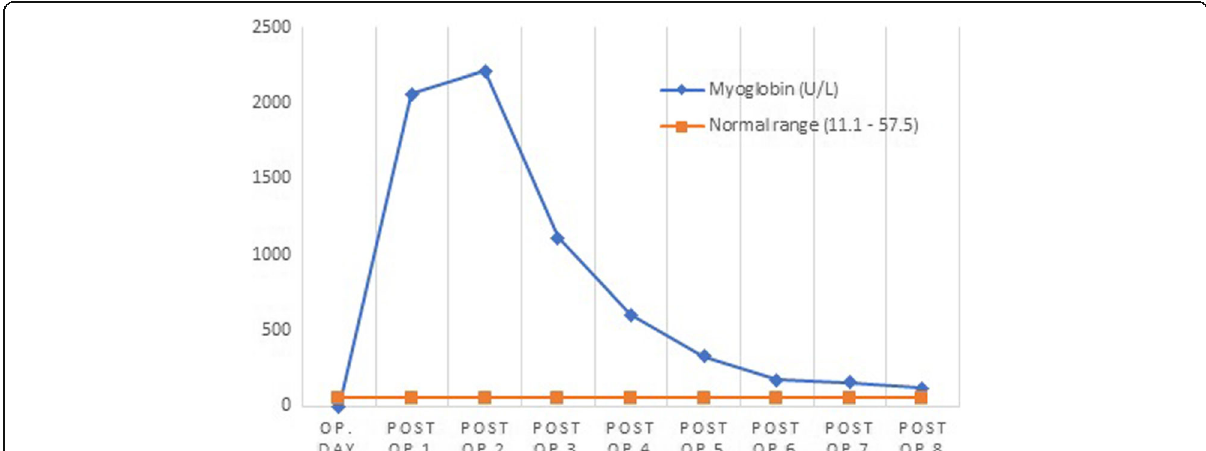
Fig. 2 The changing levels of serum myoglobin (U/L) after the operation. Serum myoglobin value sharply increased 2 days after operation followed by a dramatic escalation on the third day postoperation. However, as swift and timely diagnosis and treatment was performed, 5 days after the operation, the value of CK dropped to normal range. Abbreviations: Op., operation, Post-op, postoperative